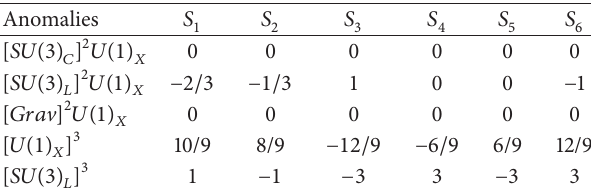
Table 1: Anomalies for 3-3-1 fermion fields